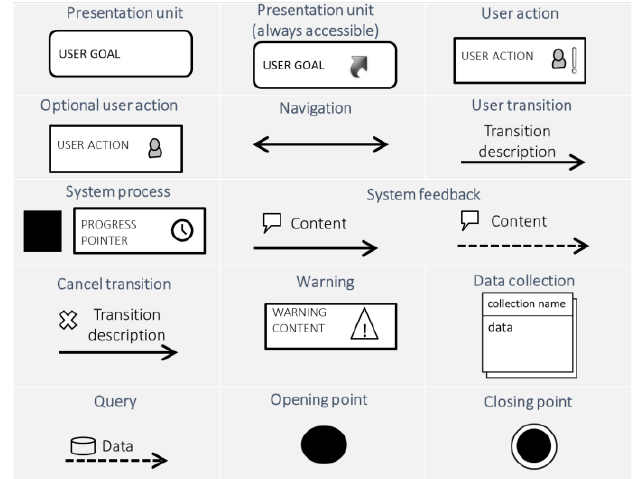
Fig. 1. Summary of the USINN elements